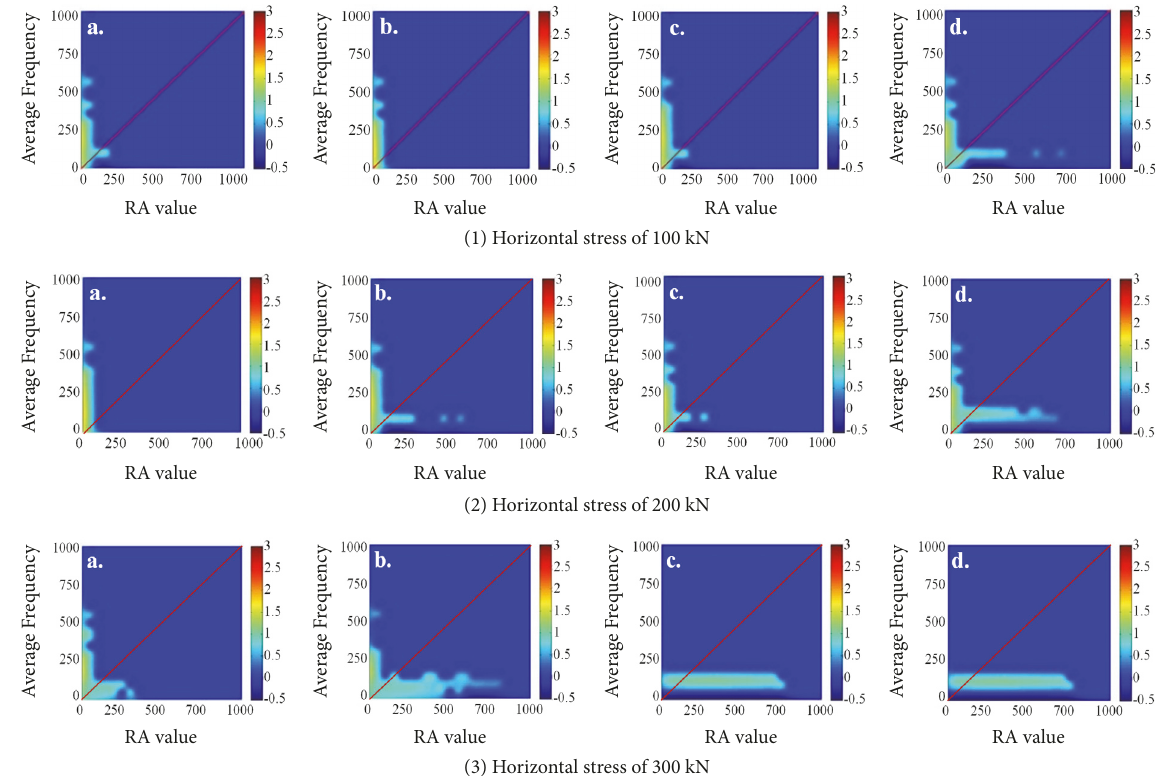
Figure 10: Distribution patterns in the rockburst evolution process under different confining pressures; ((a) the quiet period stage; (b) the particle ejection stage; (c) the flaking and particle ejection stage; (d) the complete ejection